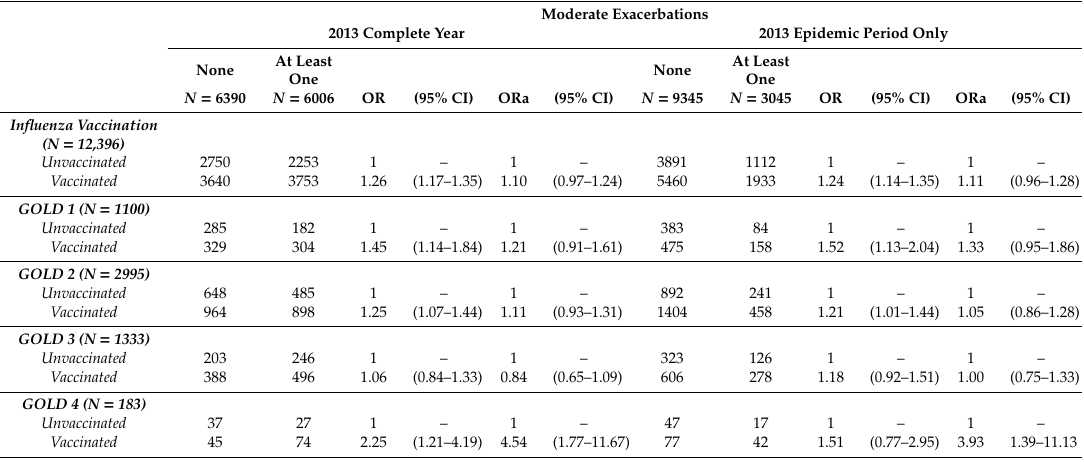
Table 4. Crude and adjusted associations between “History of Influenza Vaccination” and risk of moderate COPD Exacerbations” in all patients with a diagnosis of COPD by obstruction severity during the complete year and the epidemic